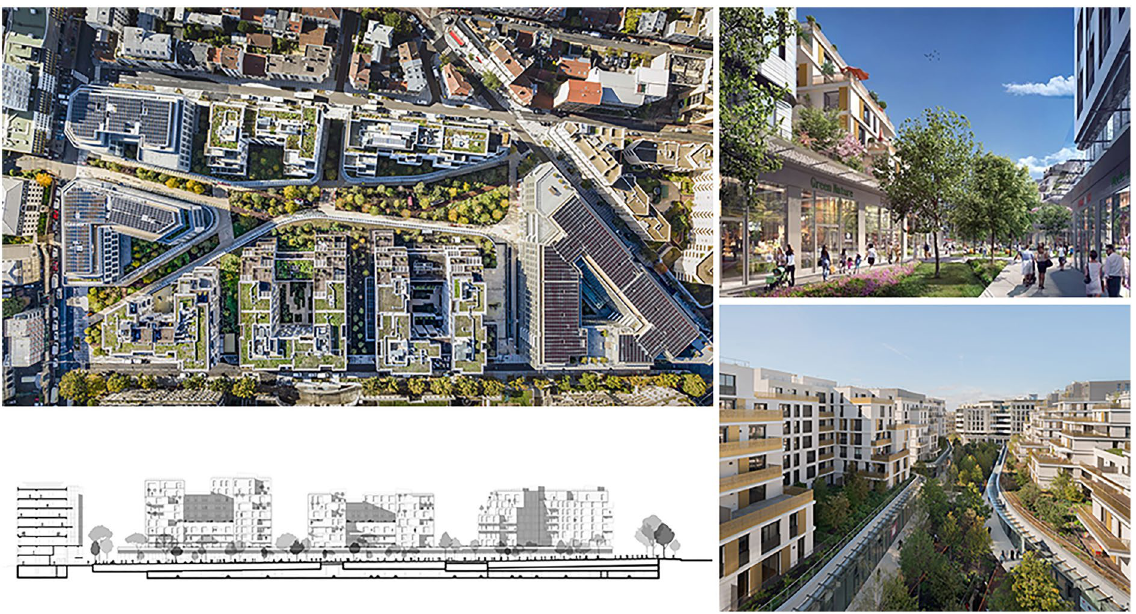
Fig. 7 "Issy Cœur de Ville" urban regeneration sites in Issy-les-Moulineaux. Source: Authors elaboration from https:// www. archd aily. com and https:// www. issy. com/ coeur- de-